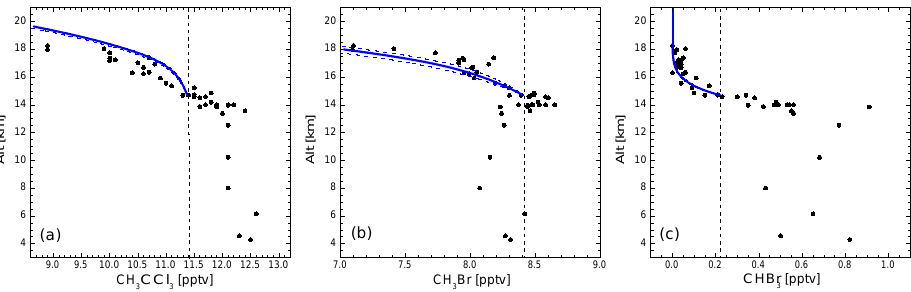
Fig. 7. Vertical distributions of (a) CH 3 CCl 3 , (b) CH 3 Br, and (c) CHBr 3 . Symbols are the same as in Fig. 5. The blue dotted lines denote the fits with ± 30% uncertainties in [OH].